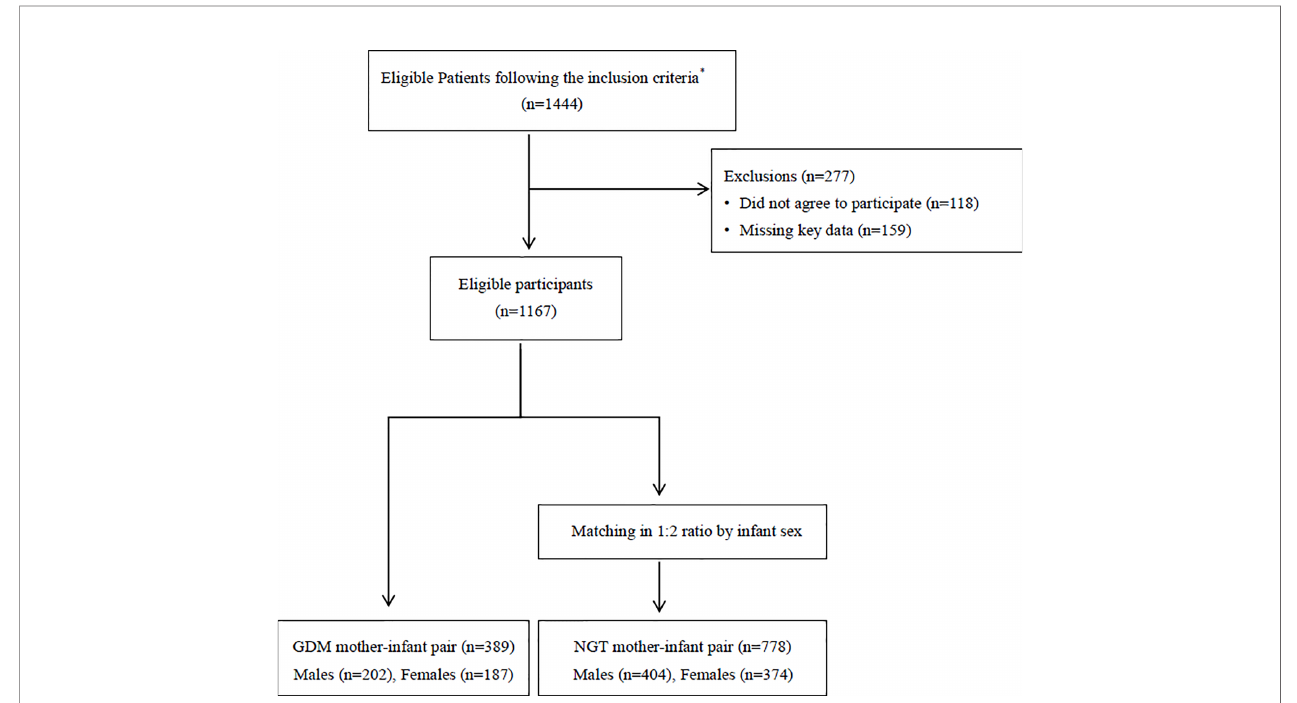
FIGURE 1 | Flow diagram summarizing the inclusion of patients with gestational diabetes in the study.*The inclusion criteria were as follows: 1) Singleton pregnancy; 2) Chinese Han origin; 3) Completion of a 2 hours, 75-g oral glucose tolerance test (OGTT) at 24 – 28 gestational weeks; 4) No history of a pre-pregnancy or early pregnancy abnormal glucose tolerance; 5) Maternal age between 18 and 45 years; 7) Live infant, and 9) Access complete medical history; GDM, gestational diabetes mellitus; NGT, normal glucose